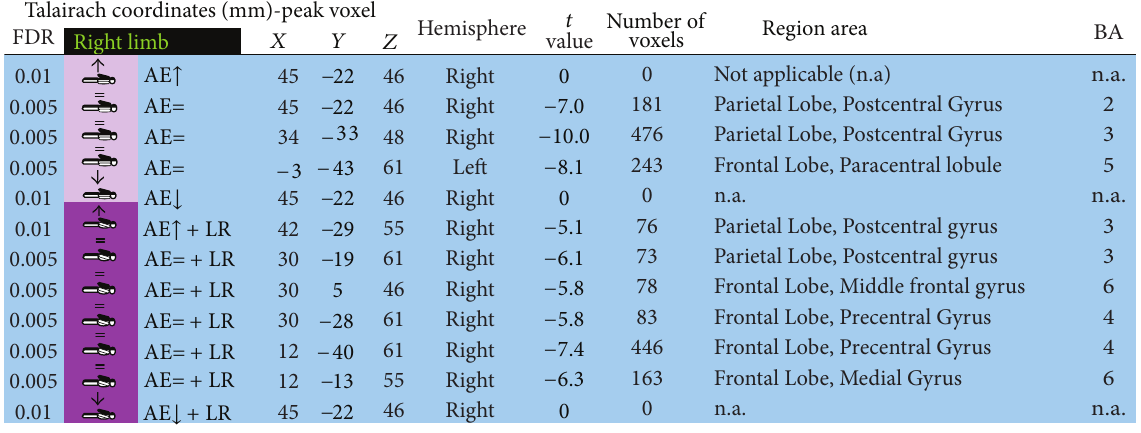
Table 2: Deactivated brain regions by isolated dominant arm elevation or combined dominant arm elevation with nondominant upper limb